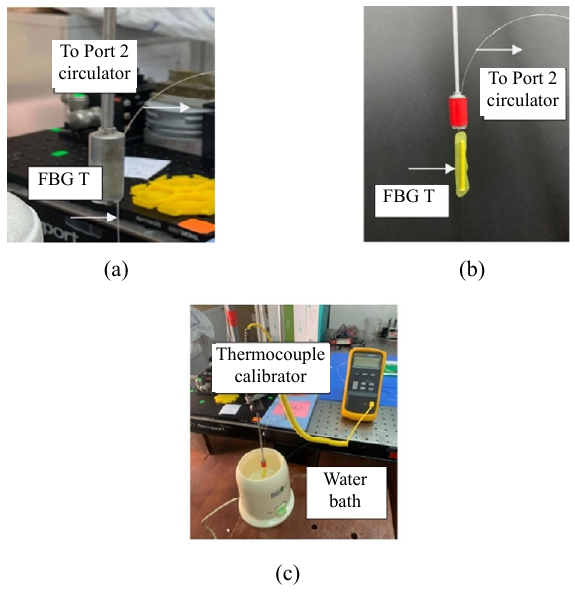
Fig. 4 Illustration of (a) the experimental setup of the embedded FBG-based strain sensor and (b) schematic diagram of interrogation system for the FBGs used (FBG 1 to FBG 6) and FBG T.